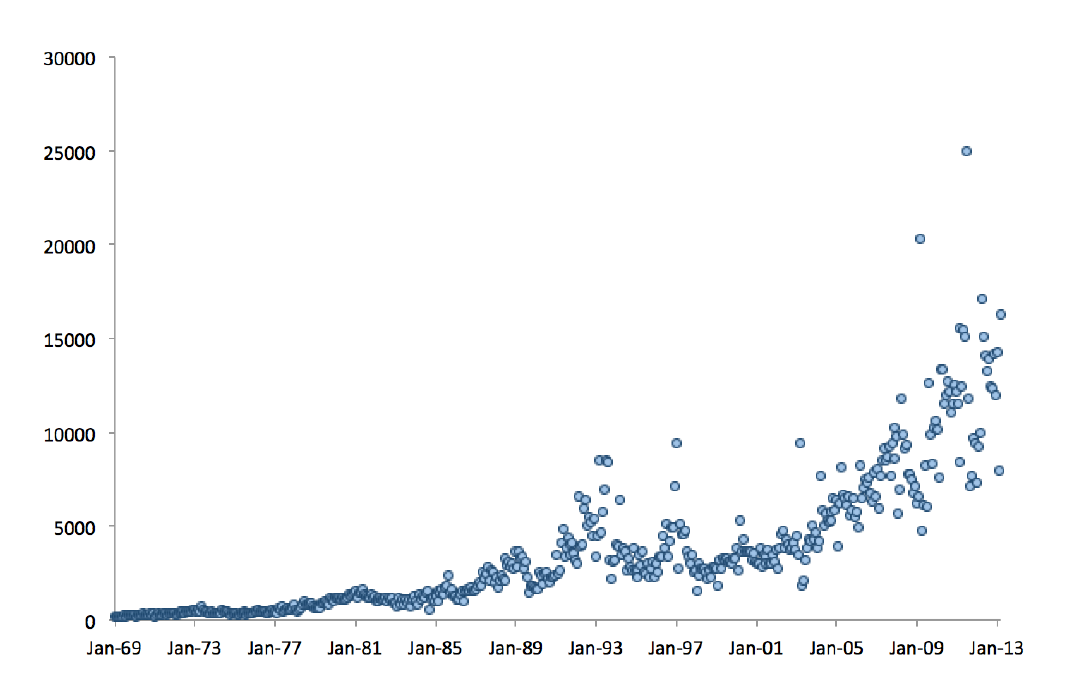
Figure 1: New Business Registrations in Hong Kong by Month 1975-2013 otherwise. With overlapping period dummies, the time period immediately preceding each dummy serves as the reference category. Two